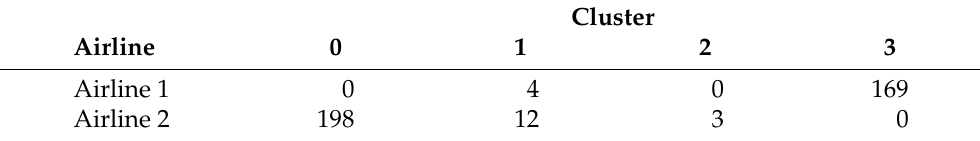
Table 1. Contingency table of airline vs. cluster for Rome Fiumicino and Warsaw Chopin airports.